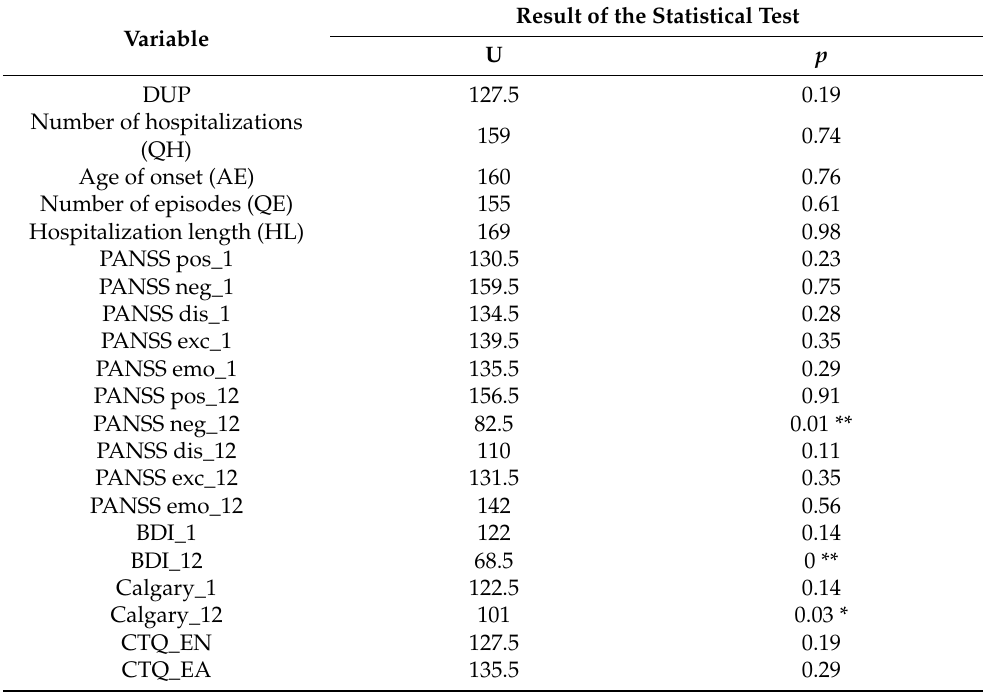
Table 8. Results of the statistical test concerning the differences in the scope of the analyzed variables, i.e., in the groups of people divided according to the functioning of the thyroid